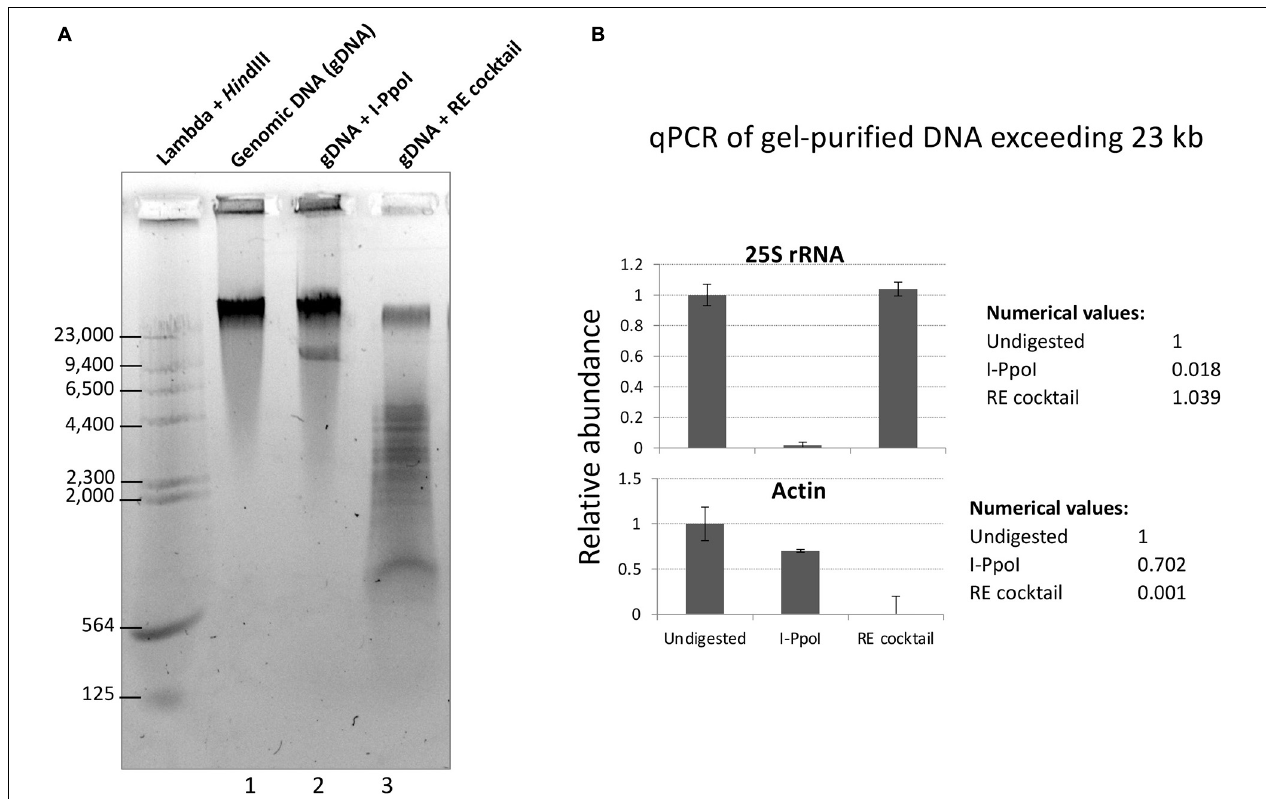
FIGURE 2 | Digestion of genomic DNA with a cocktail of six restriction endonucleases (REs) predicted not to cut rRNA genes. (A) Col-0 gDNA that was either undigested (lane 1) or digested with I-PpoI (Lane 2) or the RE cocktail (lane 3) was separated on a 0.7% agarose gel and stained with GelRed dye. Bacteriophage Lambda DNA digested with Hin dIII provided size markers. (B) Summary of quantitative PCR (qPCR) results for rRNA gene (top panel) and actin (bottom panel) detection in undigested, I-PpoI, or RE cocktail-digested samples. qPCR was performed on gDNA extracted from the top gel band, containing DNA > 23